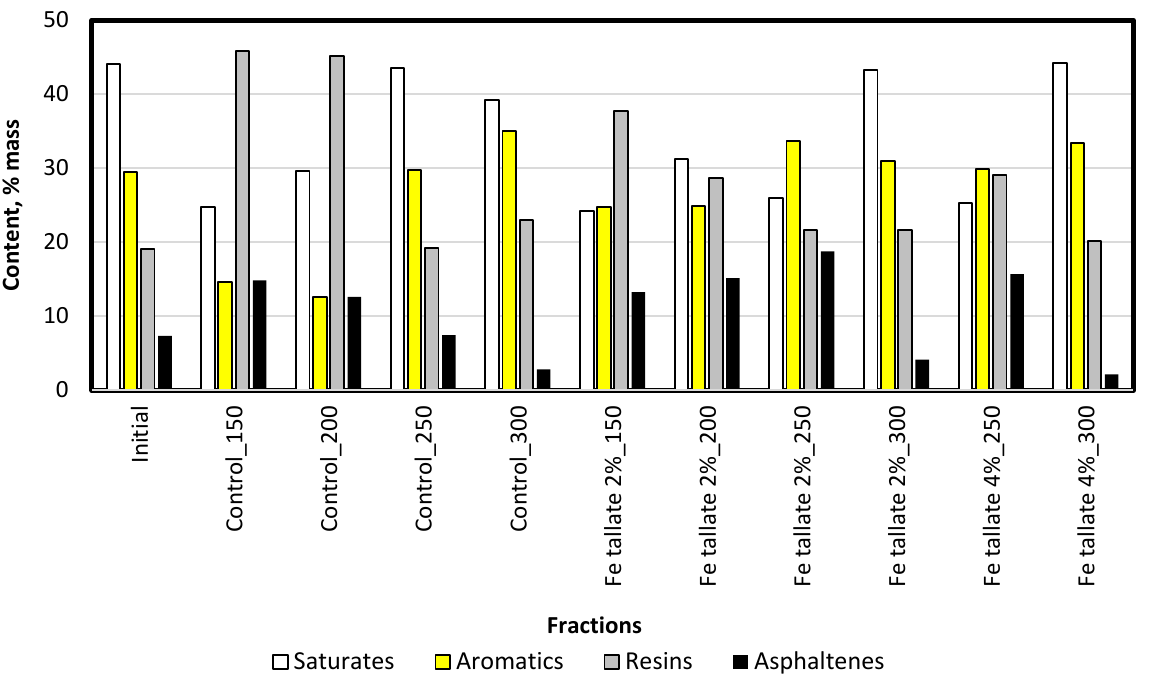
Figure 9. Component composition of the oil of the control experiment and oils after TST with iron tallate.